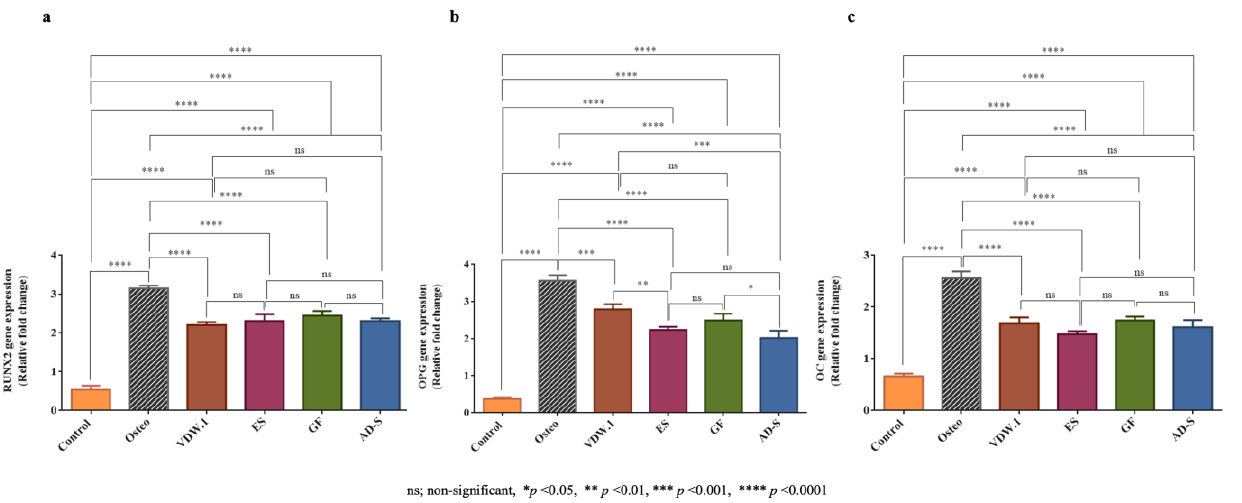
Figure 7. Relative gene expression for the different groups, given as means and standard deviation. ( a ) RUNX2 gene expression between the different sealers examined and the negative and positive control groups. ( b ) OC gene expression. ( c ). OPG gene expression.Osteo—osteogenic differentiation media, VDW.1—VDW.1Seal, ES—Endosequence BC Sealer HiFlow, GF—GuttaFlow-2, AD-S—ADSeal.